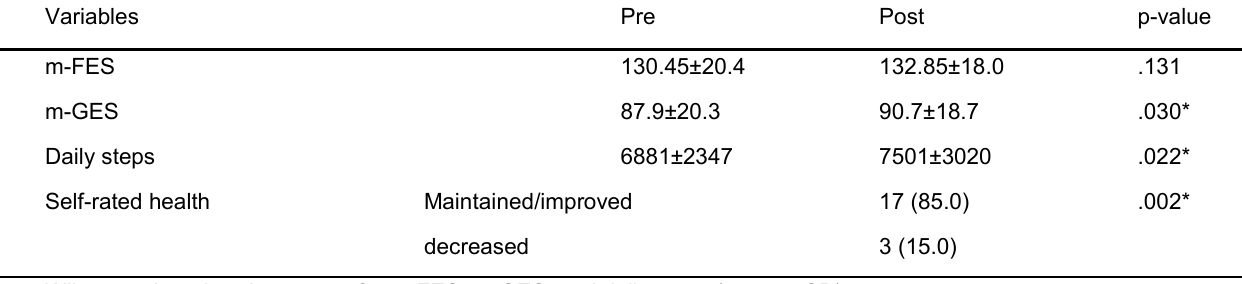
Results of Pre- and Post-intervention